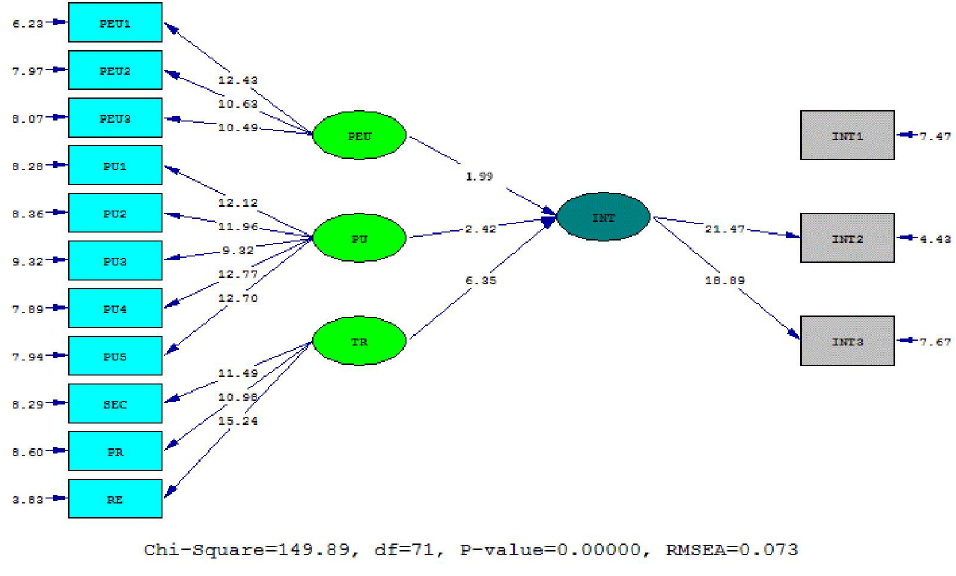
Fig. 2. The results of standard values for structural equation